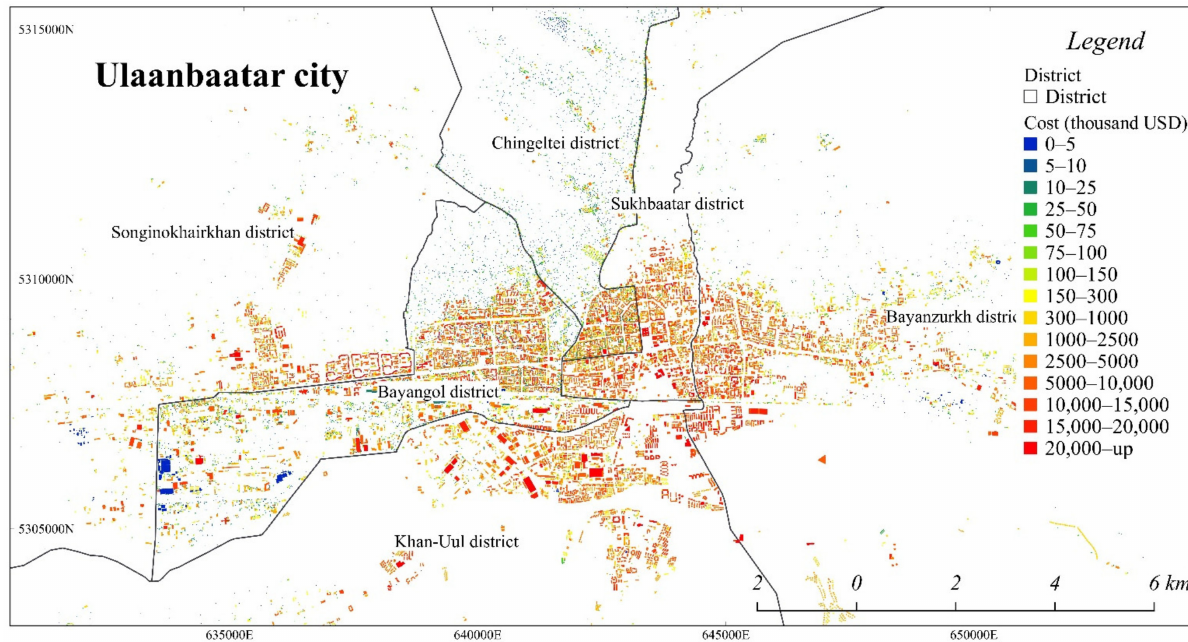
Figure 6. Distribution of construction costs (thousand USD) in